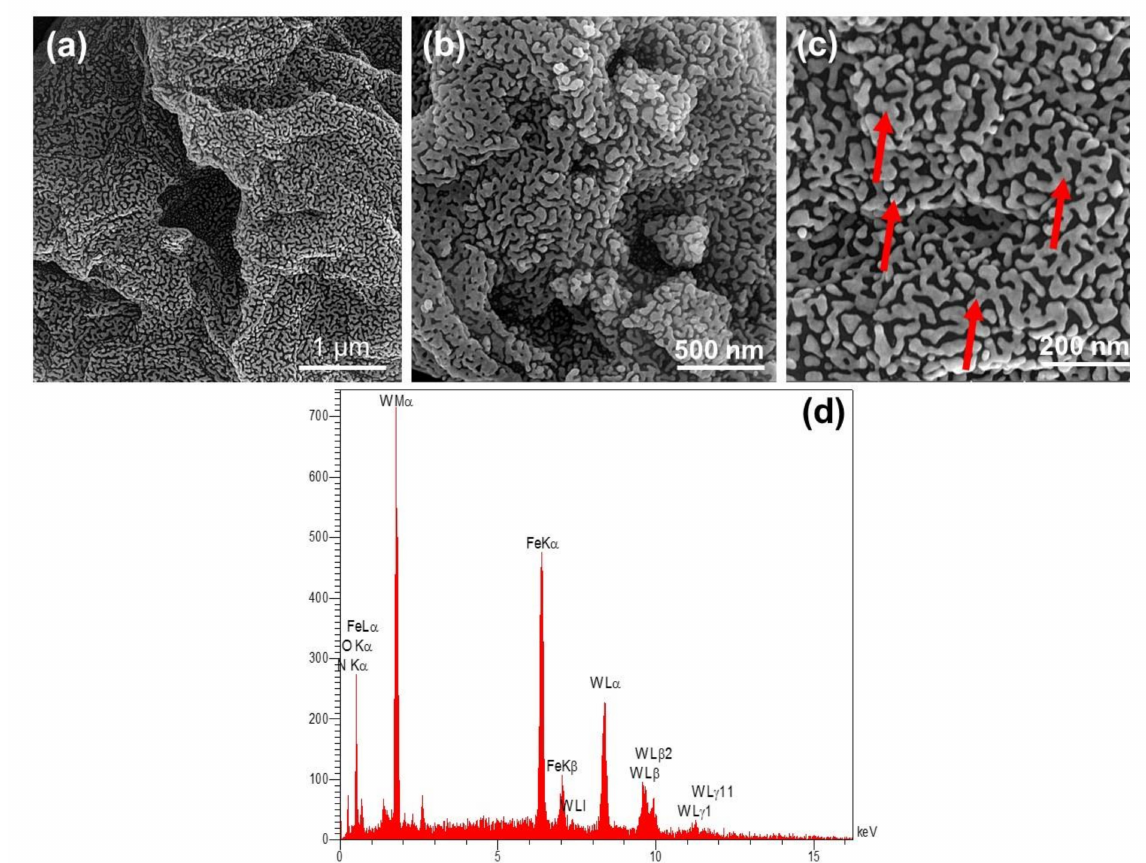
Figure 4. ( a – c ) FESEM images of hybrid GO-ITN at diverse scales (red arrows showing the interconnected iron tungsten nitride’s structure on the surface of GO) along with ( d ) related EDAX analysis of this hybrid